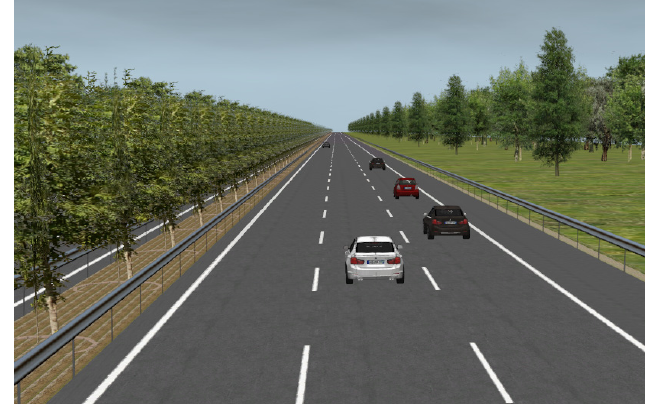
Note. ‘C’ denotes the clear weather with the visibility distance >1000 m; ‘F’ denotes the light fog condition with the visibility distance of 140 m.